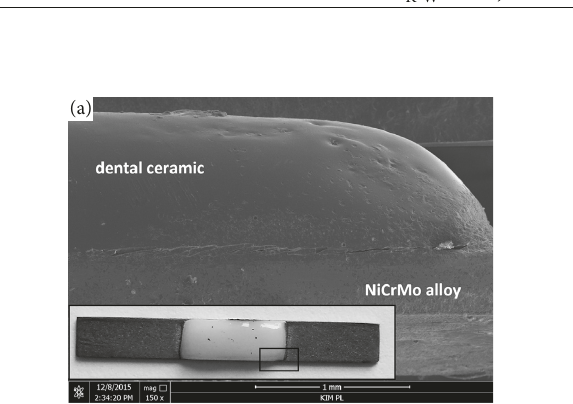
Table 4: The mean values of the τ group of